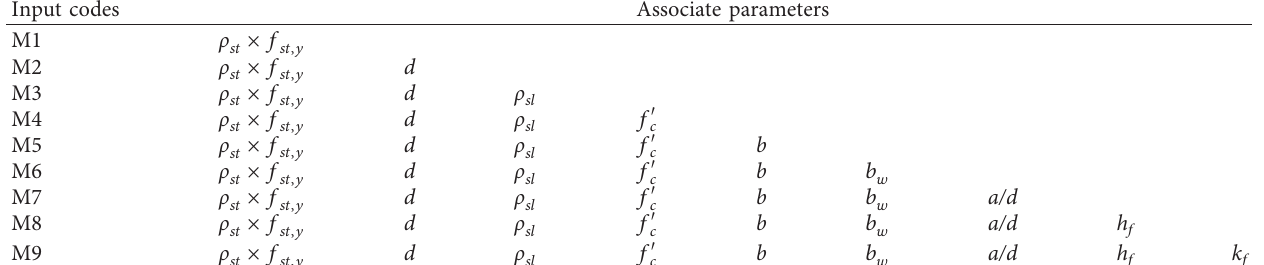
Table 1: The initiated predictors’ codes for the applied predictive models based on the statistical correlation. Input